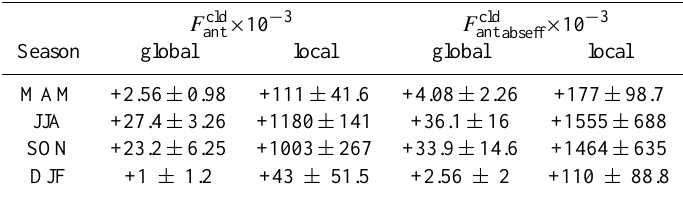
Table 4. Anthropogenic aerosol RF at TOA in cloudy scenes in Wm − 2 for region TSEA (see Fig. 1). Results are displayed for different seasons (see Table 1), averaged on global and local scale. F cld ant and F cld ant effect calculation,